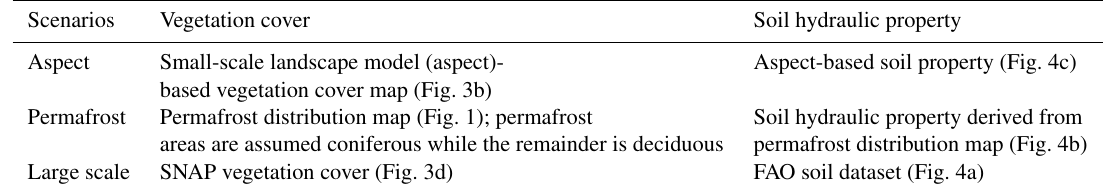
Table 4. Definition of the parameterization scenarios with respect to corresponding vegetation cover and soil property parameters. Scenarios Vegetation cover